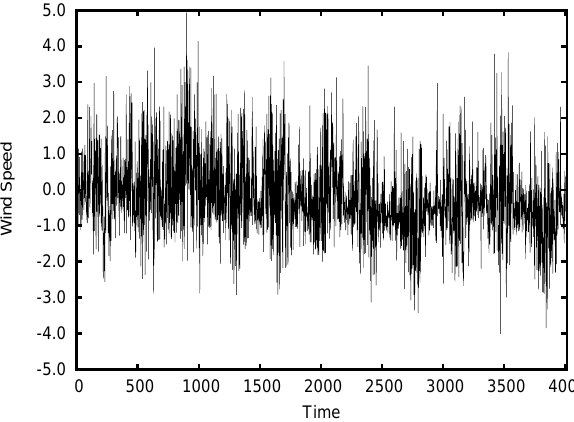
Fig. 3. Time series of the detrended denoised daily mean wind speed shown in Fig. 1.